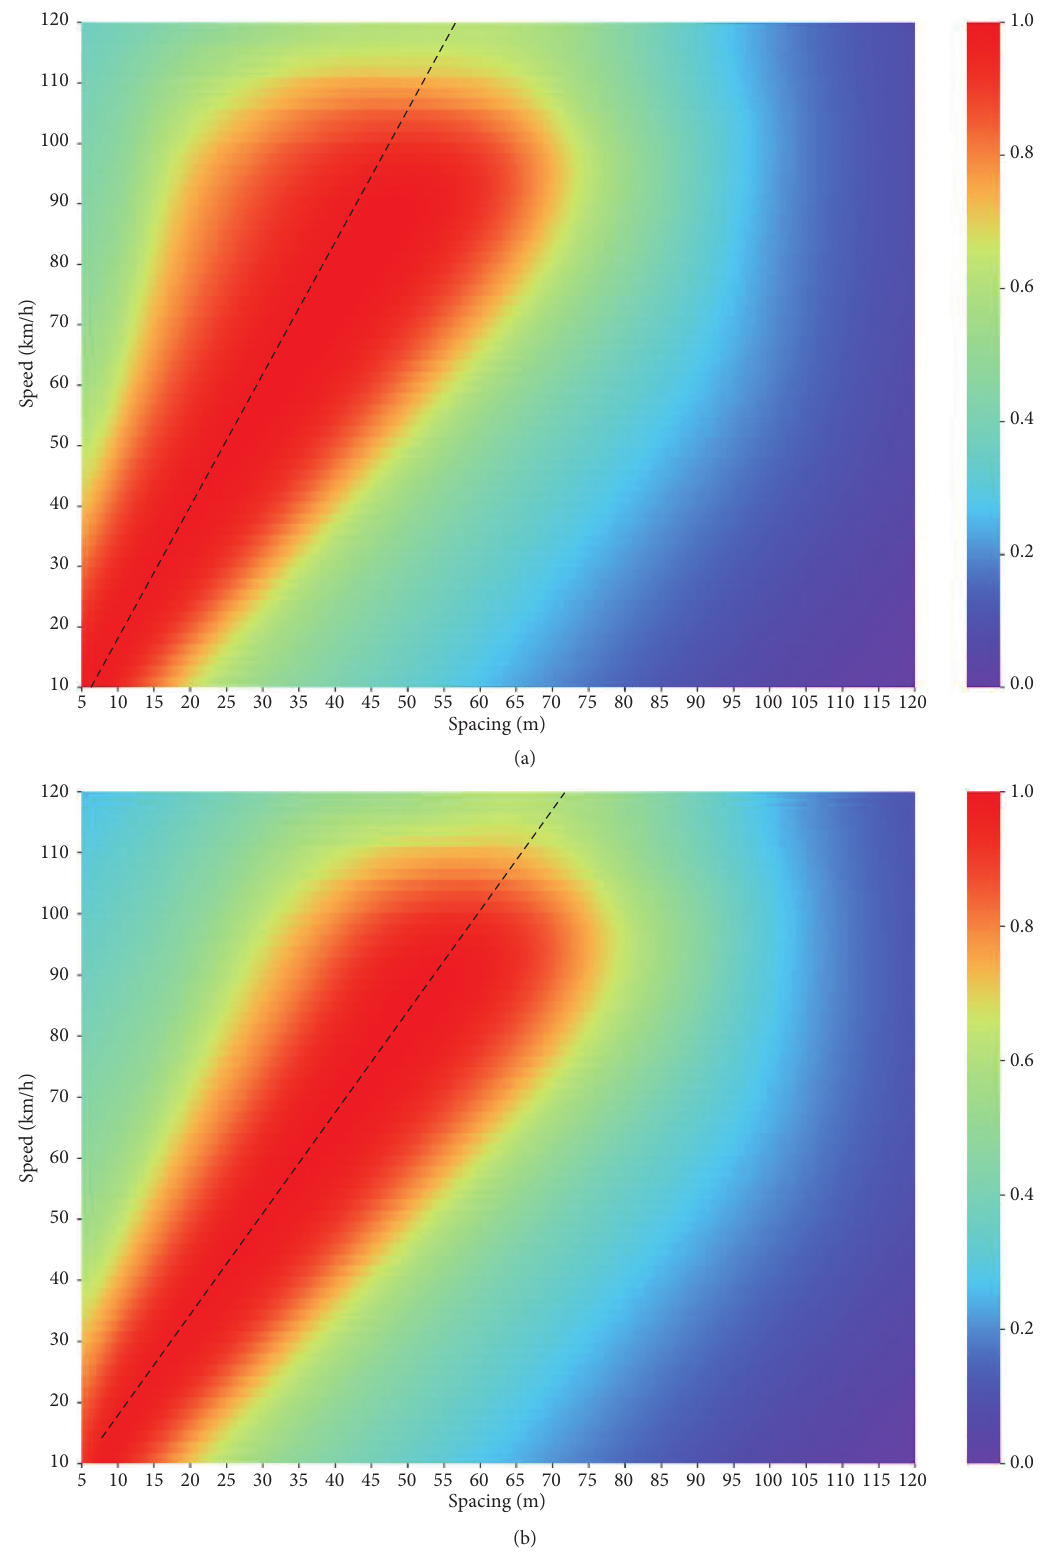
Figure 9: The comparison of the value ( V ) for (a) the aggressive drivers and (b) the conservative drivers. The colors indicate the value of every state in the state space, and the black-dashed line lies in the center of the high-value area, indicating the direction of the high-value